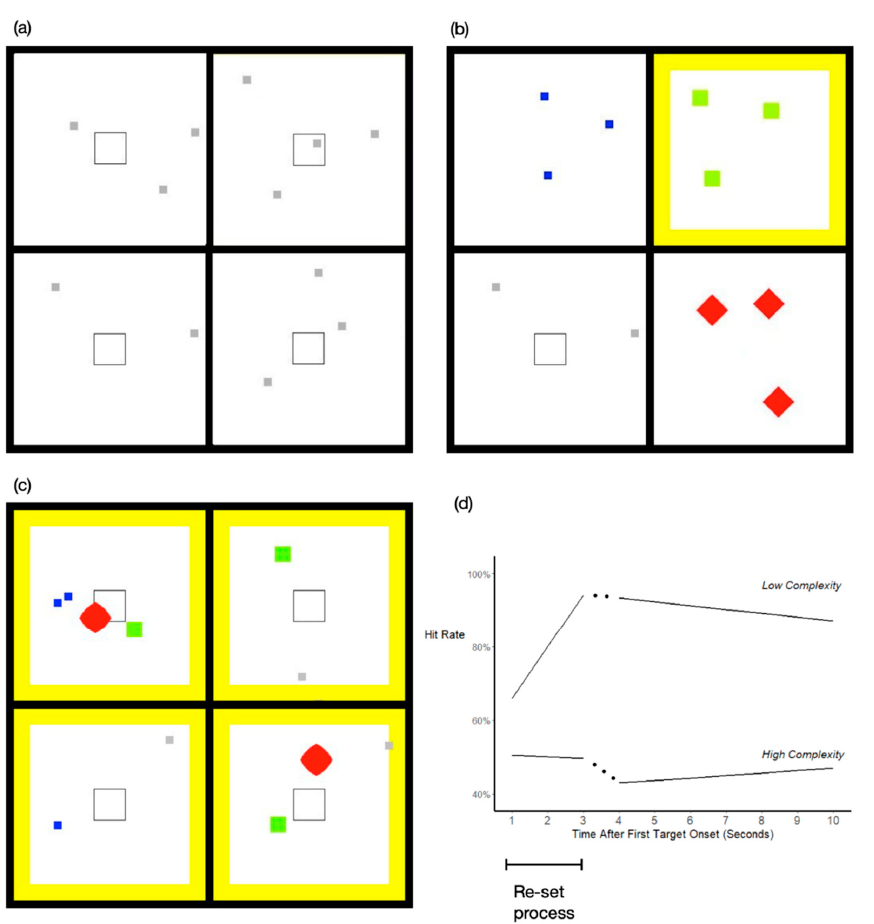
Figure 1. ( a – c ) Snapshots from 3 conditions: ( a ) single-task, ( b ) multiple-task grouped, and ( c ) mixed multi-task. The timing and location of the tokens appeared random, but were structured by algorithm; thus the tokens in the figures are at different stages in their lifetimes. ( d ) shows lines fit to data from a single-task condition (“low complexity” on top, from Experiment 3), and the highest complexity condition (“high complexity” on bottom, from Experiment 2, mixed multi-tasking). Data were fit separately for Times 1–3 s and 4–10